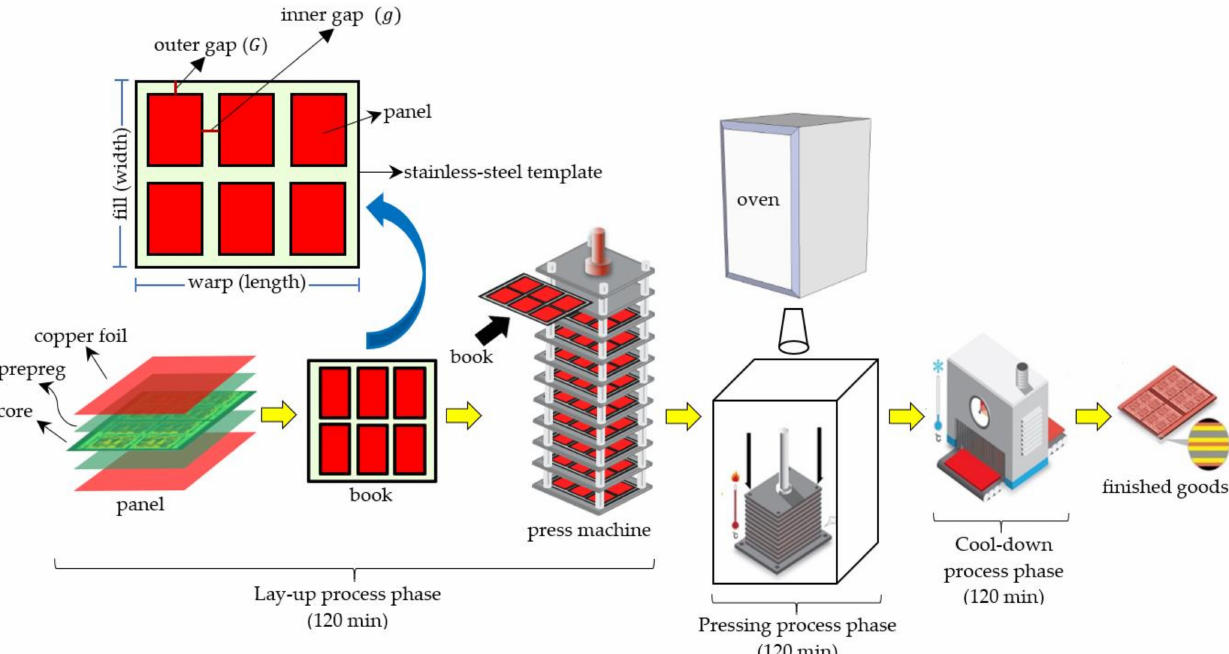
Figure 1. The overall processes of one cycle of a press